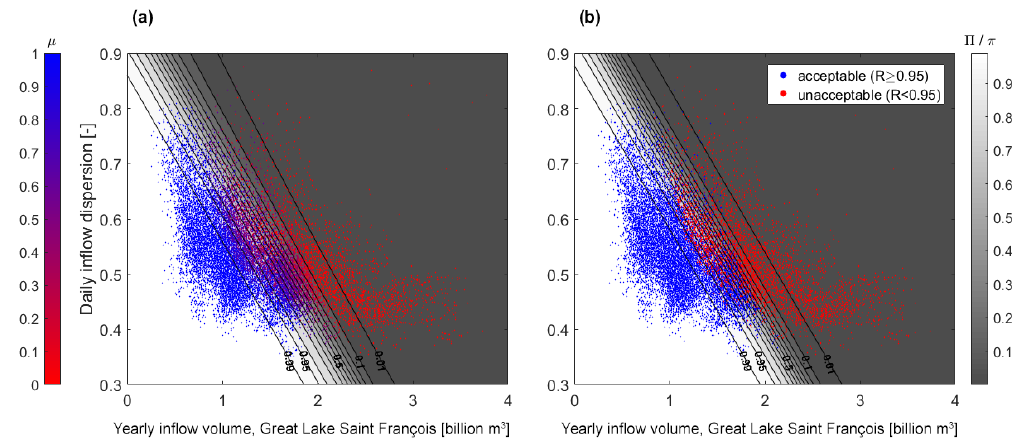
Figure 7. Acceptability of sampled outcomes and logistic regressions. (a) Fuzzy outcomes and the possibility of an acceptable perfor- mance (cid:53) . (b) Binary outcomes and the probability of an acceptable performance π